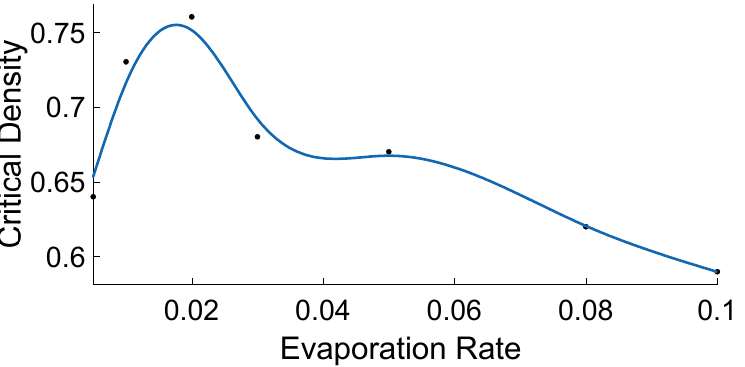
Figure 3. Critical densities of fundamental diagrams from ATM simulations are plotted against evaporation rate ( r e ) of the corresponding simulations. For the simulations, variables other than r e were kept constant: L = 1000 cells , σ sat = 80 p units / cell , v min = 0.15 cells / time step , and τ = 1 p units